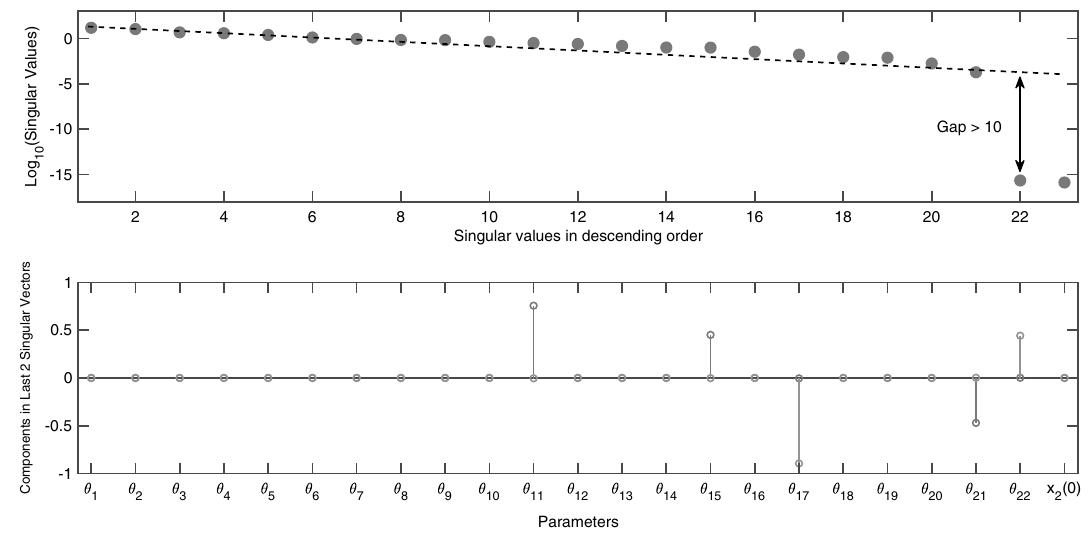
Figure 4. Identifiability signature of the JAK/STAT model ( M 4 ). (Top) The 2 singular values beyond the gap calculated whilst measuring Eqs. (36)–(43) and using the initial conditions defined in Eq. (21). These suggest model unidentifiability and that there are two sets of totally correlated parameters. (Bottom) Entries in the last two columns of matrix V related to the 2 zero singular values. The nonzero elements indicate the union between two potential sets of totally correlated parameters, { θ 11 , θ 15 , θ 17 , θ 21 , θ 22 }